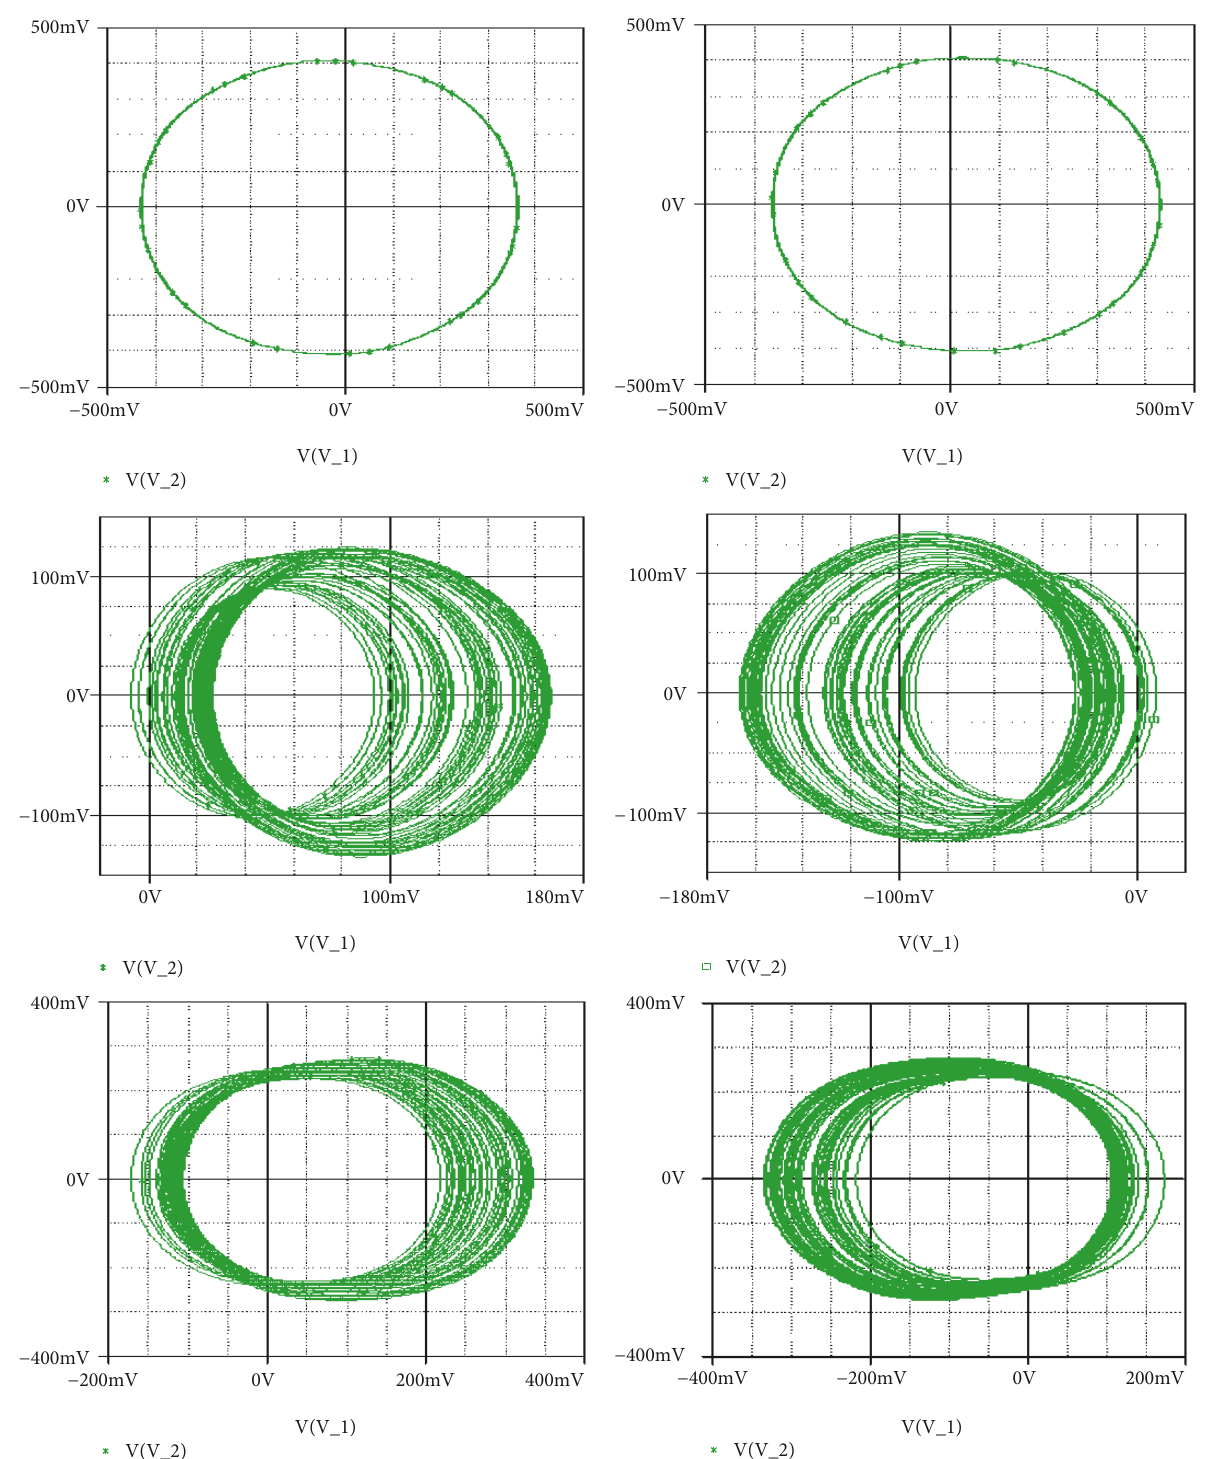
Figure 16: Pspice simulation results showing the coexistence of six different attractors for 𝑅𝑎2 = 16.5𝑘Ω (two pairs of chaotic attractors and a pair of period-1 limit cycle). Initial states are indicated in Table